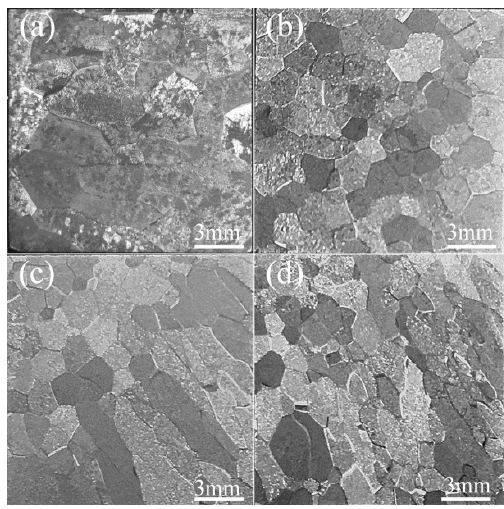
Figure 2. The microstructures of Ti6Al4V-xEr casting alloys: ( a ) x = 0; ( b ) x = 0.2; ( c ) x = 0.4; ( d ) x = 0.6 wt %.